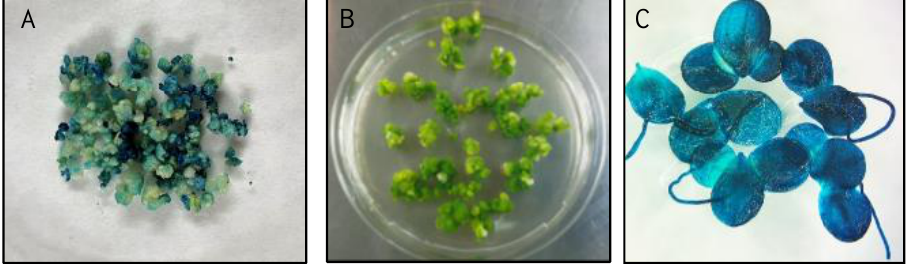
9 of 20 Figure 3. Callus induction and regeneration of L.minor ZH0403. ( A ) Frond; ( B ) callus induced from an explant 3 weeks after inoculation; ( C ) callus induced from an explant 6 weeks after inoculation;